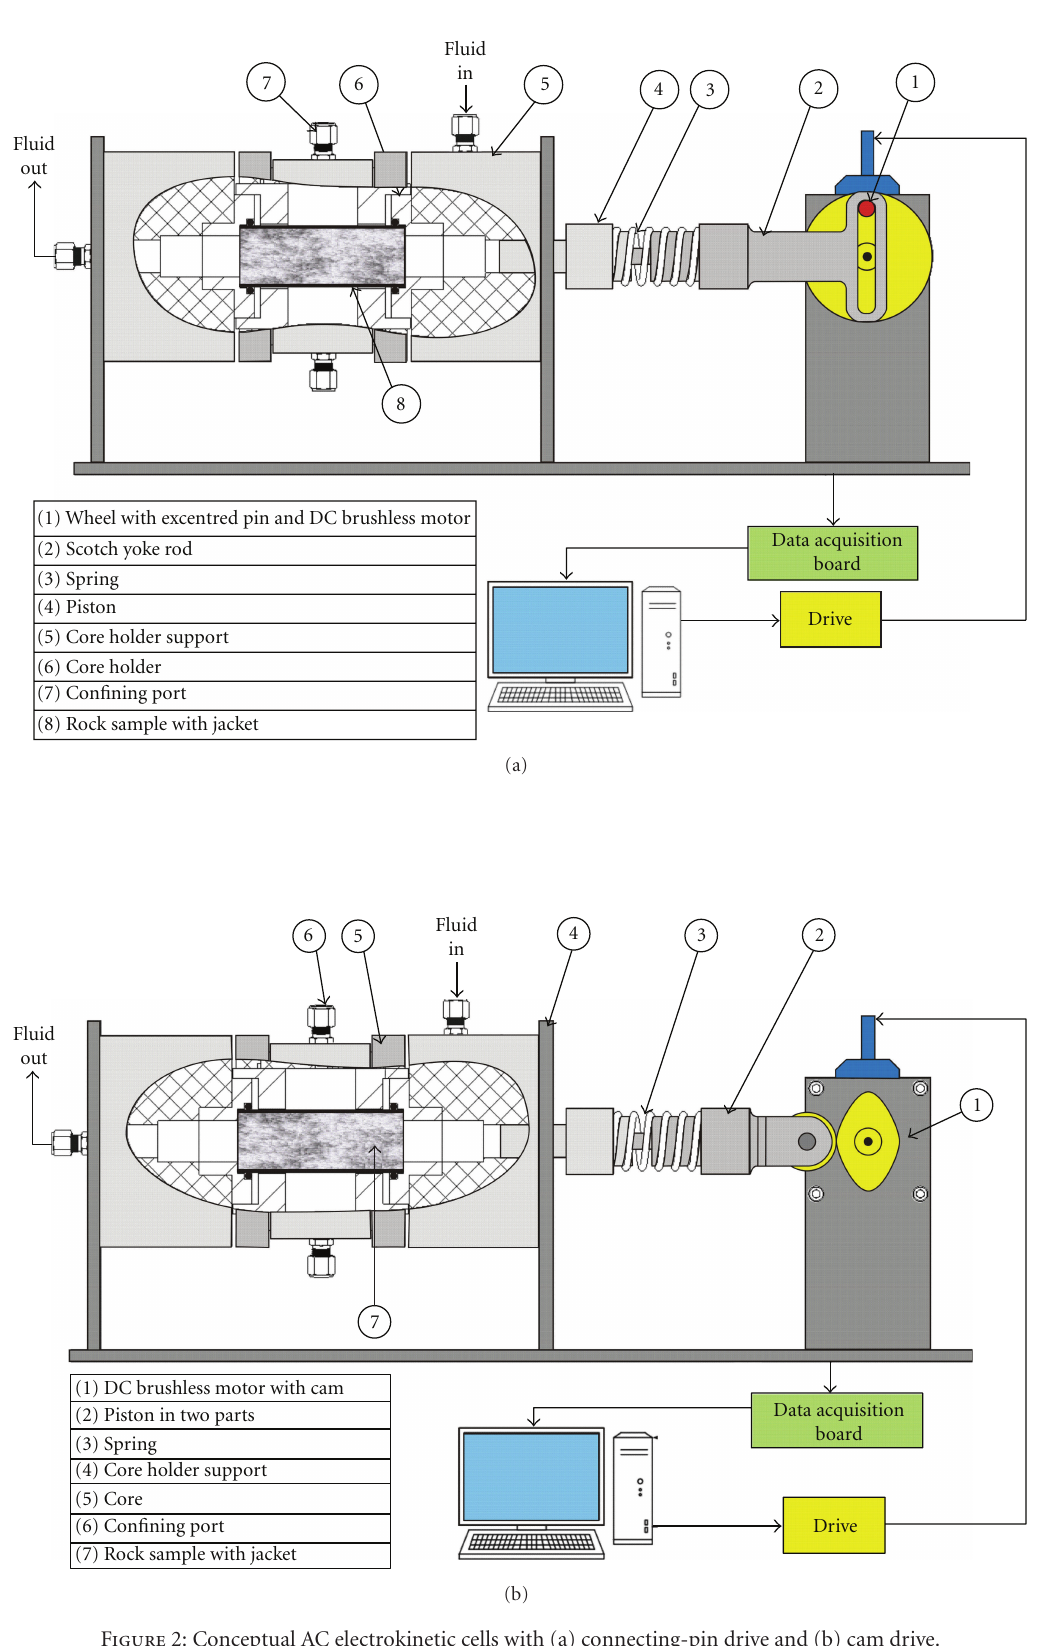
Figure 2: Conceptual AC electrokinetic cells with (a) connecting-pin drive and (b) cam